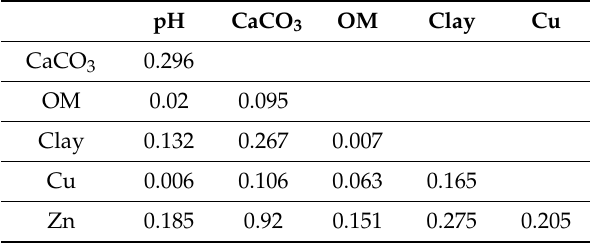
Table 4. Correlation matrix (surficial horizons). Significative correlation at 0.05 level (bilateral).